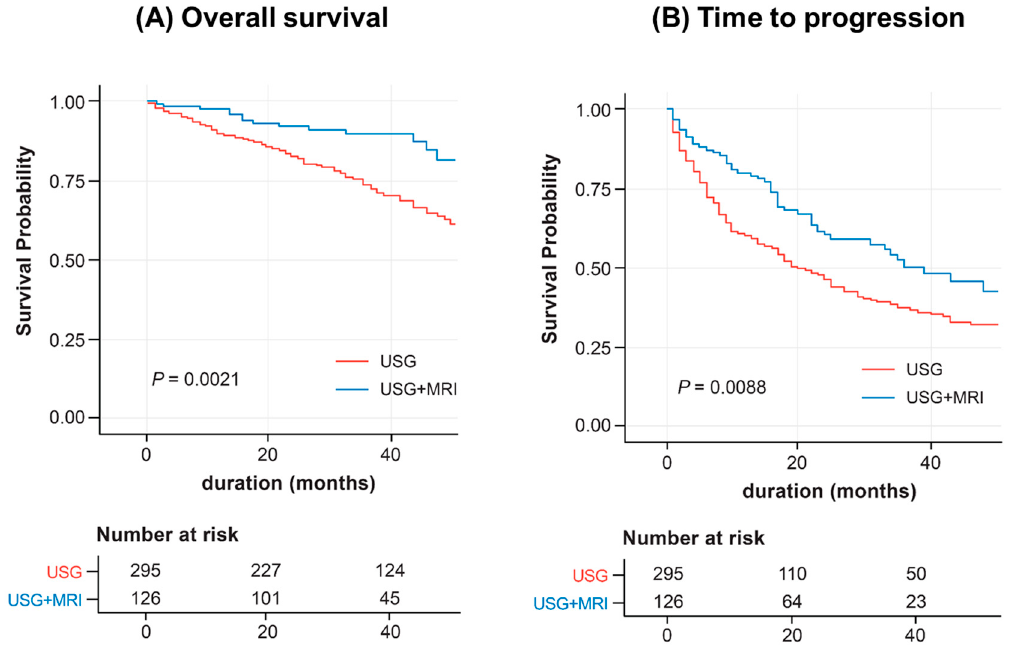
Figure 2. Overall survival and time to progression in patients surveilled by USG alone or USG and Gd-EOB-DTPA-enhanced MRI (unmatched cohort). ( A ) Overall survival. ( B ) Time to